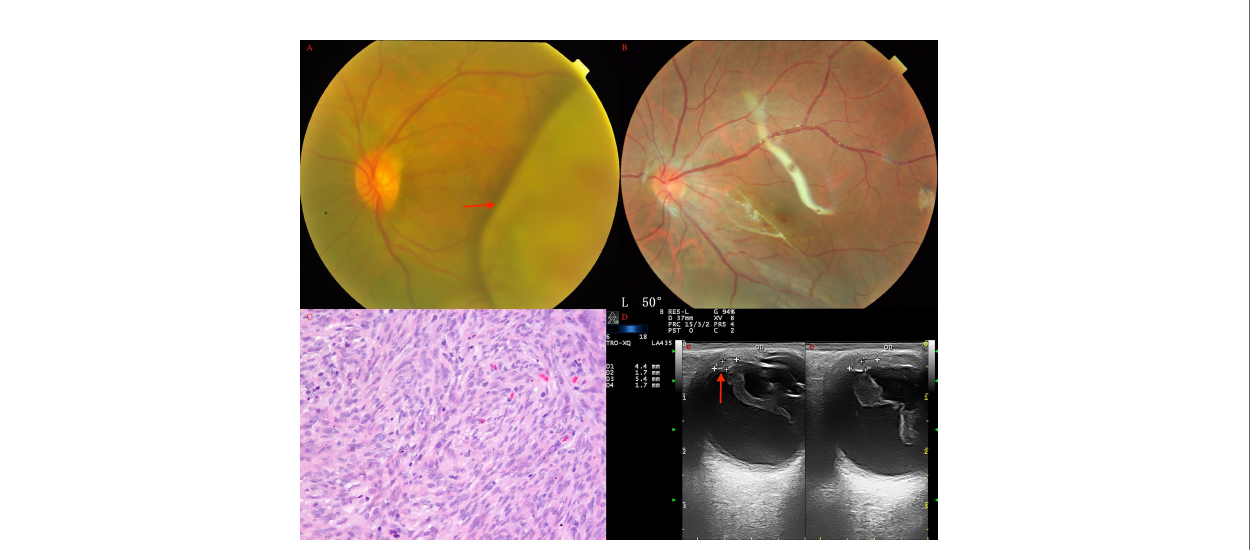
FIGURE 5 | Choroidal schwannoma/neurilemmoma (arrow) in a 43-year-old man before (A) and after (B) PTSU combined with MVRE. (C) Histopathology revealed that the tumor consisted of spindle cells in a fascicular arrangement with long eosinophilic cytoplasmic processes and cells loosely arranged in a mucoid matrix (HE, × 200); (D) CDI showed two pedunculated masses (arrow) with inconsistent re fl ectivity of moderate intensity and no choroidal excavation, with arterial blood signals in the tumor.